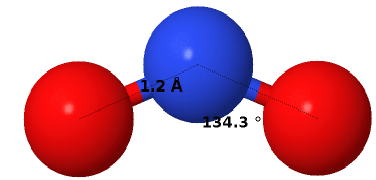
Fig. 7. Structure of NO2 molecule before the adsorption process (Non-adsorbed state).